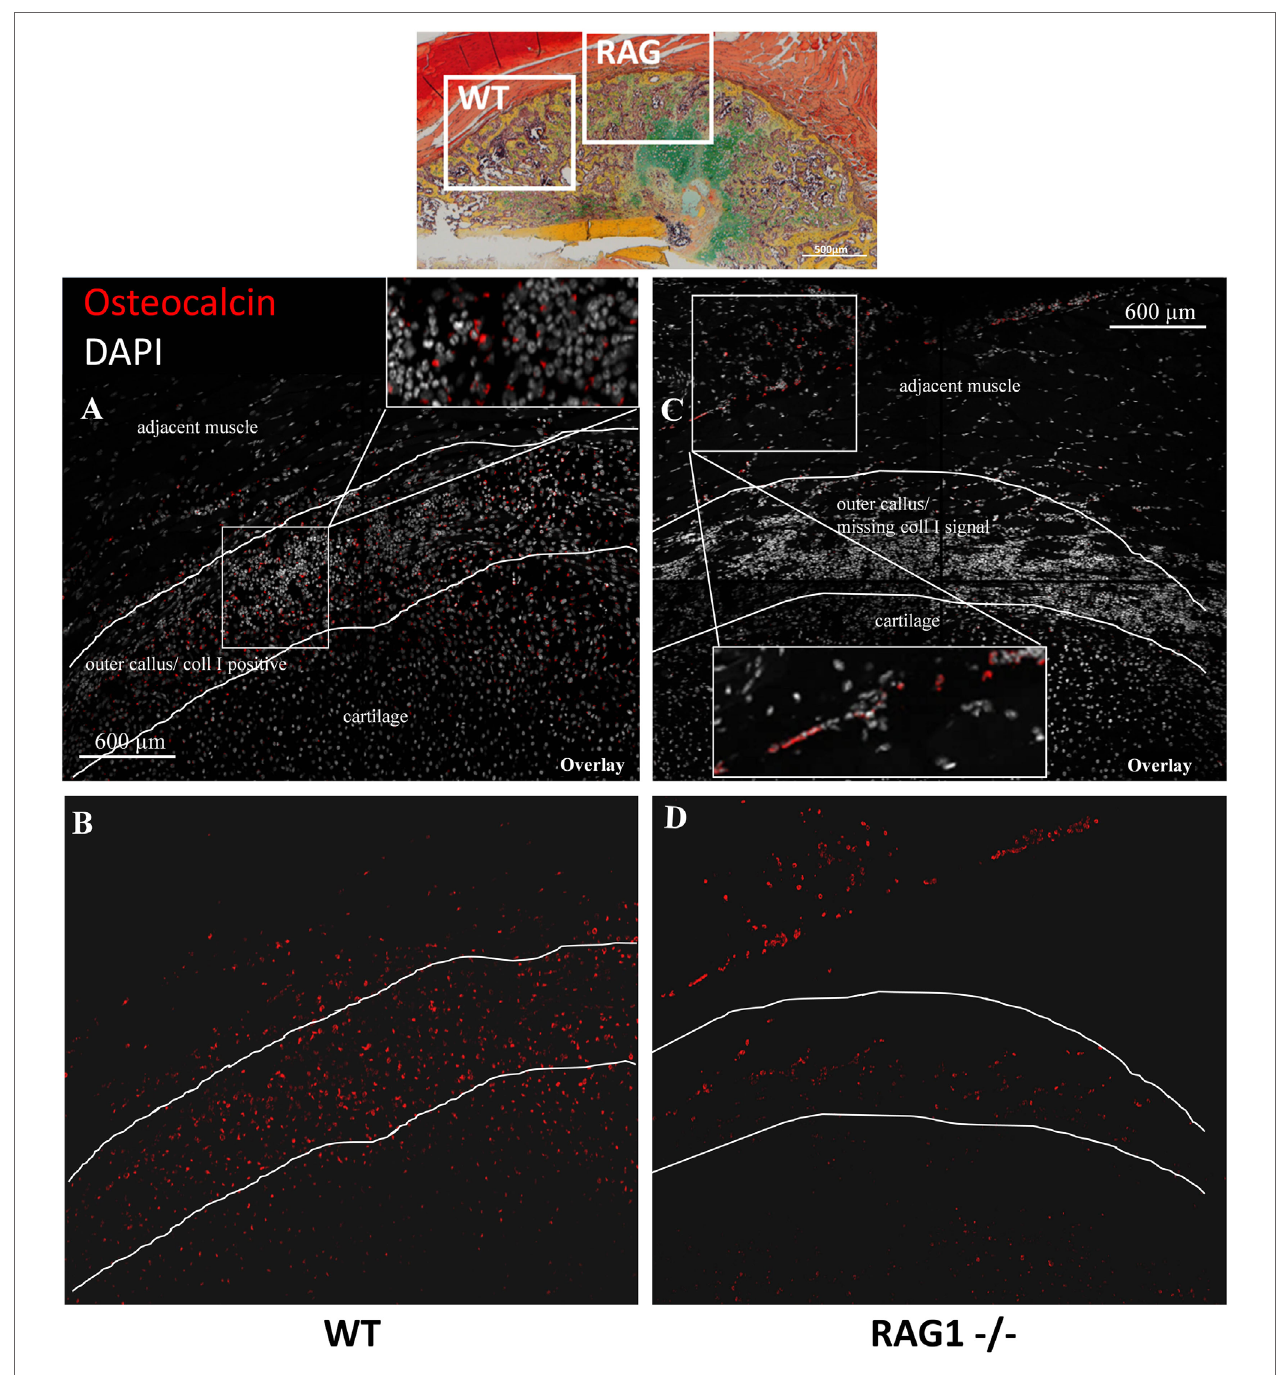
FigUre 6 | Osteocalcin (Ocn)-positive cells show an aberrant localization in the fracture callus of animals healing without mature T and B cells . Immunohistological images of Ocn-positive cells in the fracture callus of WT (a,B) and recombination activating gene 1 homozygous knockout (RAG1 − / − ) animals (c,D) at day 14 reveal an abundance of these cells in the collagen type I-positive outer rim of the wild-type callus (a) while these cells are scarce in the equivalent location in RAG1 − / − animals (c) . In the RAG1 − / − animals, a layer of Ocn-positive cells appears in the soft tissue adjacent to the fracture callus (red = Ocn; gray = DAPI to stain cell nuclei).